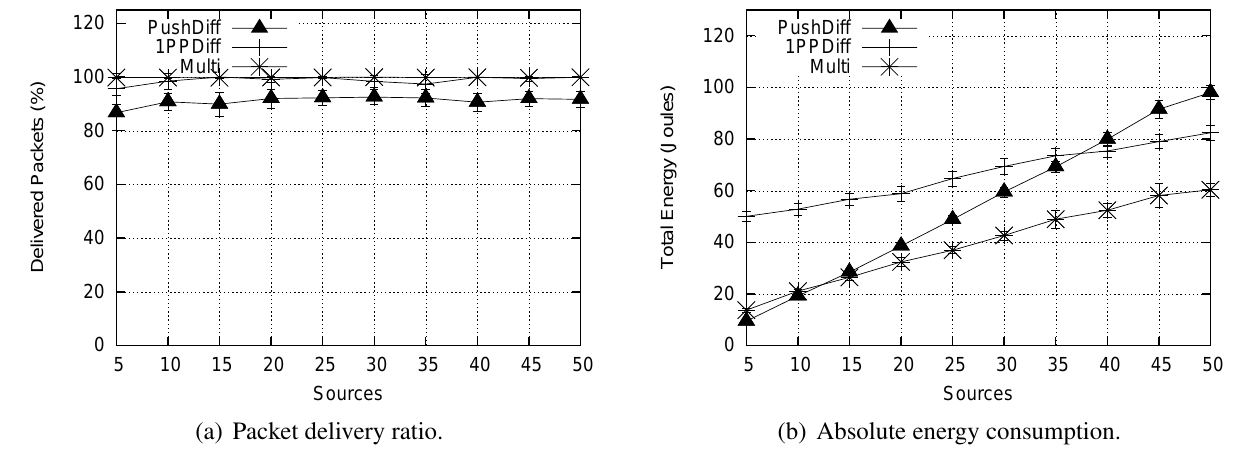
Figure 11. Comparison with Diffusion versions in the correlated detection